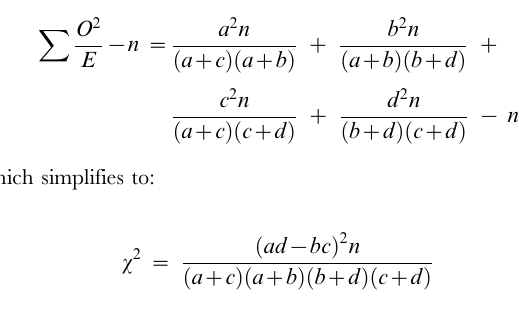
Table 3. Expected allele counts in x 2 statistic calculation.